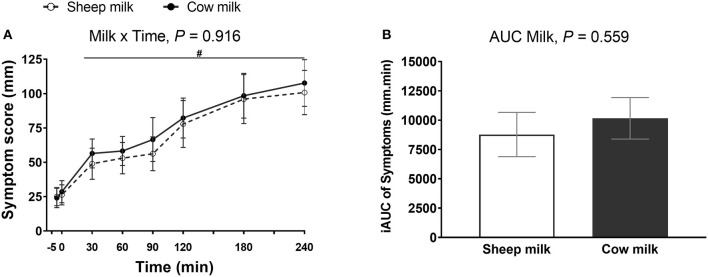
Subjective VAS scores (sum of abdominal cramps, abdominal rumbling, flatulence, diarrhea, and vomiting) (A) at multiple timepoints and (B) 4-h incremental area under the curve (iAUC) following cow milk and sheep milk ingestion (n = 30). Values are presented as means ± SEM. Data for multiple time points were compared using repeated general liner model with milk and time compared within-subject and iAUC was compared using Student's paired t-test. There was no milk × time interaction, P = 0.916 and iAUC, P = 0.559. There was a significant time effect (A), P < 0.001. #denotes indicated time points were significantly different from baseline.